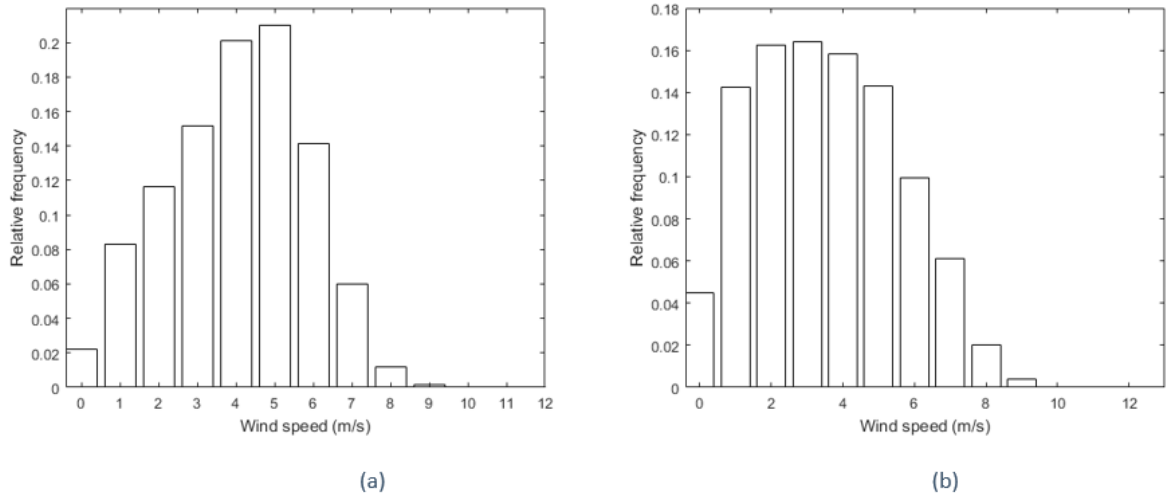
Figure 4. Wind speed distribution on the sites of Cotonou ( a ) and Lomé ( b ) at 10 m high.